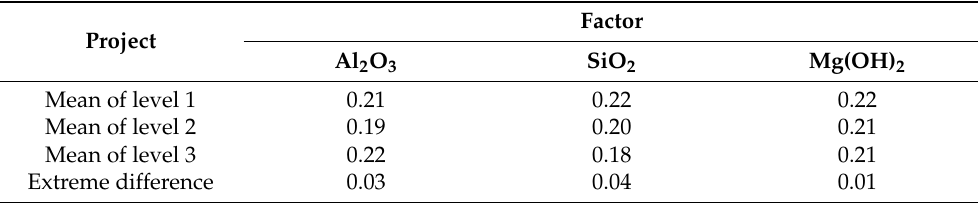
Table 5. Mean and extreme difference analysis of water absorption for each factor (%).